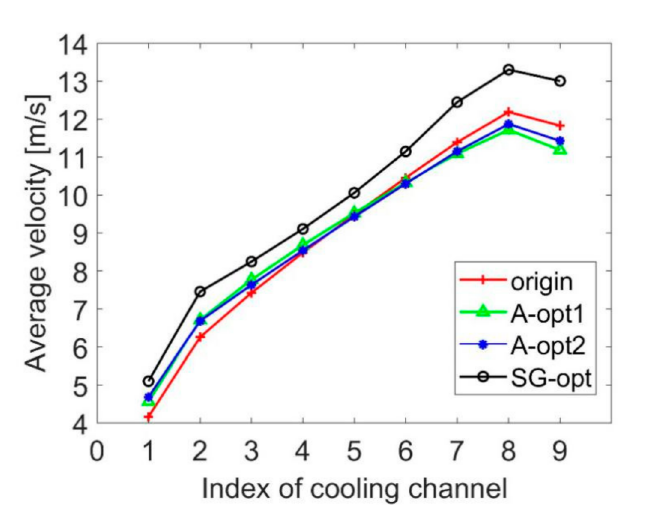
Figure 16. Comparison of air velocities in the cooling channels before and after